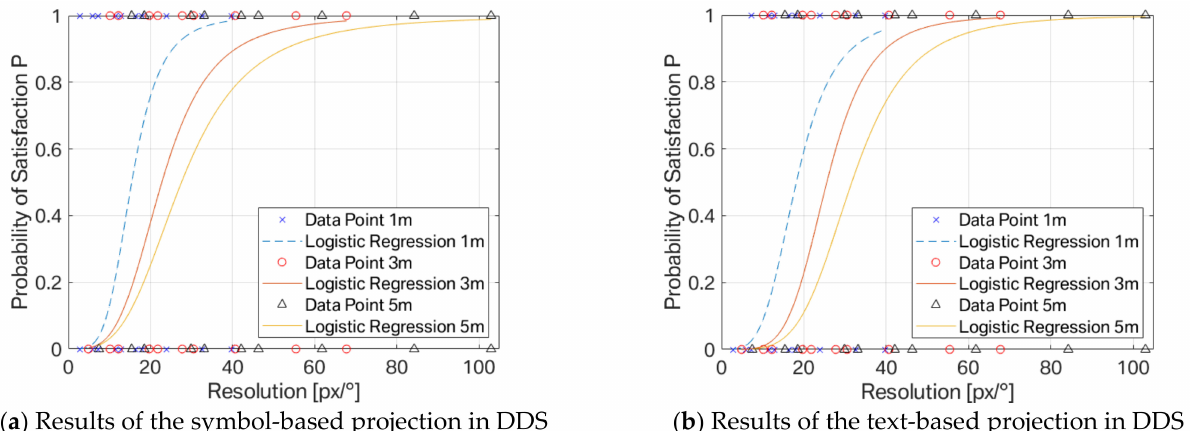
Figure 5. Results of the analyzed data by using the logistic regressing Equations (3) and (4) for extract- ing the 90% threshold for the resolution in px/ ◦ with the corresponding probability of satisfaction in the DDS. ( a ) Detailed illustration of the logistic regression of the symbol-based projection in the DDS, including the raw data, which is marked with “X” for 1 m data, with circles for 3 m data and triangles for 5 m data; ( b ) Detailed logistic regression of the text-based projection in the DDS including the raw data which is marked with X for 1 m data, with circles for 3 m data and triangles for 5 m